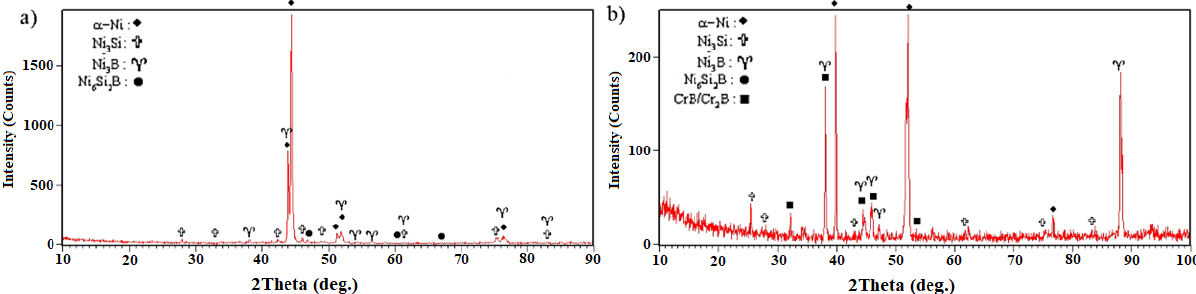
Figure 15. XRD patterns of fracture surfaces with different conditions: ( a ) 1010 °C/10 min and ( b ) 1050 °C/10 min.